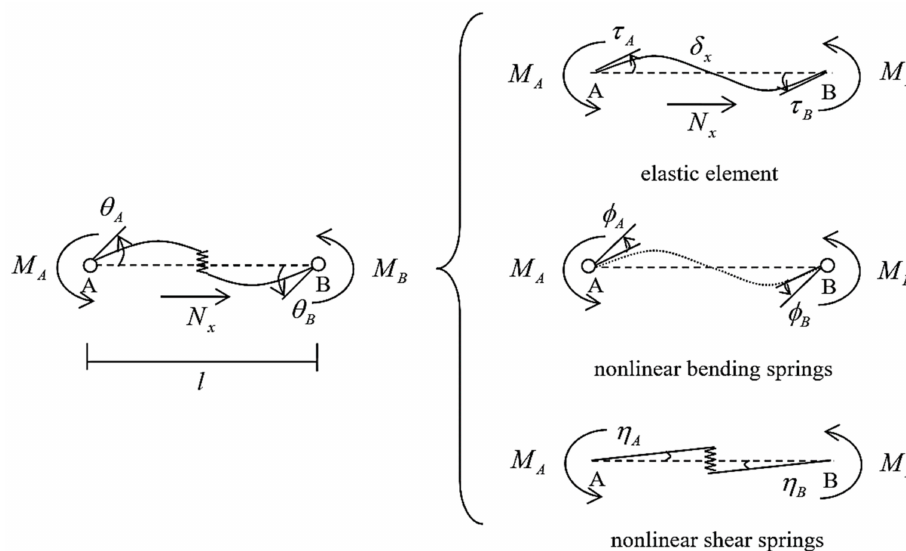
Figure 5. Elastic, nonlinearbending, andnonlinearshearspringsforelementsmodeledbySTERA_3D[26].